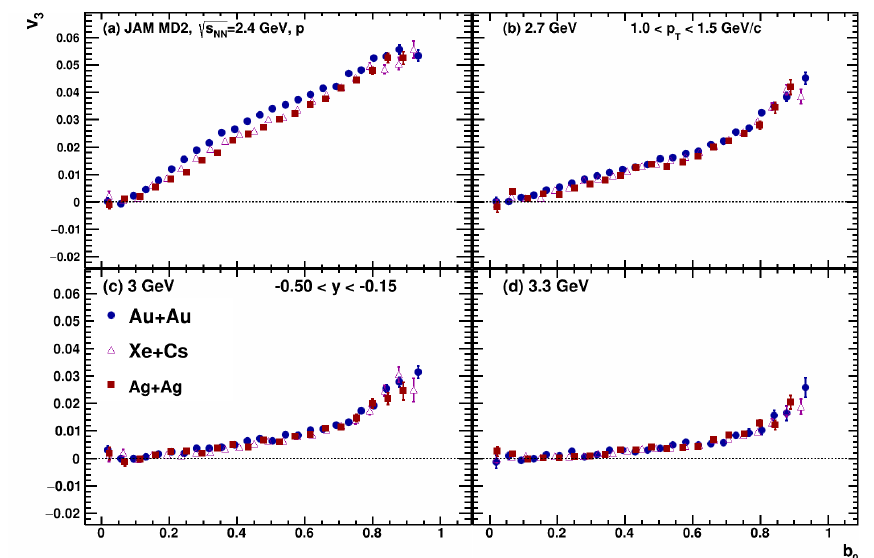
Figure 25. Scaled impact parameter b 0 dependence of triangular flow v 3 of protons in the transverse momentum interval 1.0 < p T < 1.5 GeV/c and rapidity interval − 0.5 < | y cm | < − 0.15 from Au + Au (closed circles), Xe + Cs (open triangles), Ag + Ag (closed boxes) collisions at energies (panel ( a )), 2.7 GeV (panel ( b )), 3 GeV (panel ( c )) and 3.3 GeV (panel ( d )). The results for JAM model with hard momentum dependent mean-field MD2 ( K 0 = 380 MeV)